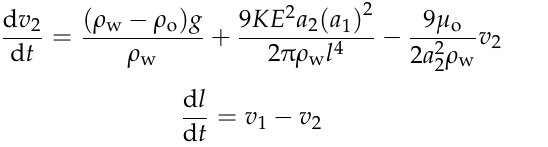
Figure 2. Schematic of the whole desalter unit indicating ( a ) general grid of the whole desalter without showing the electrodes, ( b ) inlet of emulsion and water outlet and ( c ) oil